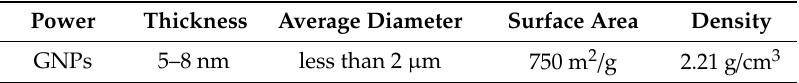
Table 2. Characteristics of GNPs.